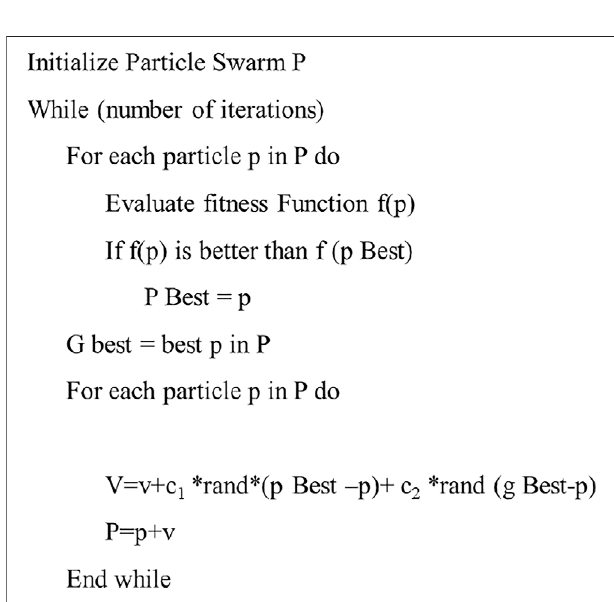
FIGURE 2 | Pseudo-code of standard